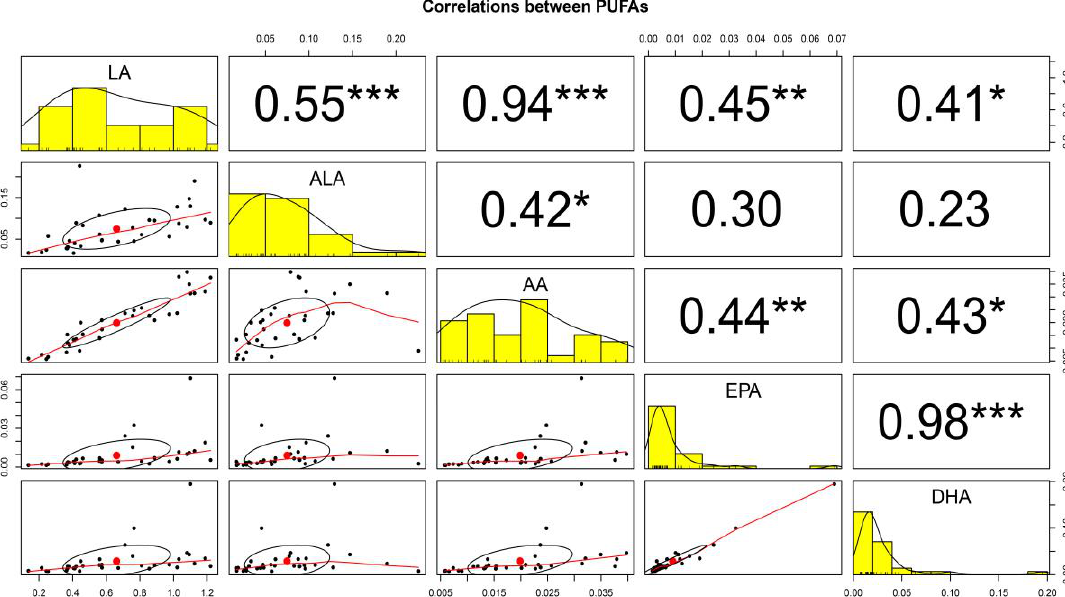
Figure 3. The correlations between polyunsaturated fatty acids (PUFA) contents in HM from mothers in Korea are graphically shown. The x-axis in each scatter plot represents the column variable, the y-axis the row variable. A histogram of values is represented on the diagonal. The points in the middle of the ellipse below the diagonal represent the points determined by the mean values of the x-axis and y- axis variables. The correlation between two variables is represented by the shape of the ellipse; the more the ellipse is stretched, the stronger its correlation. The curve drawn by the scatter plot represents the